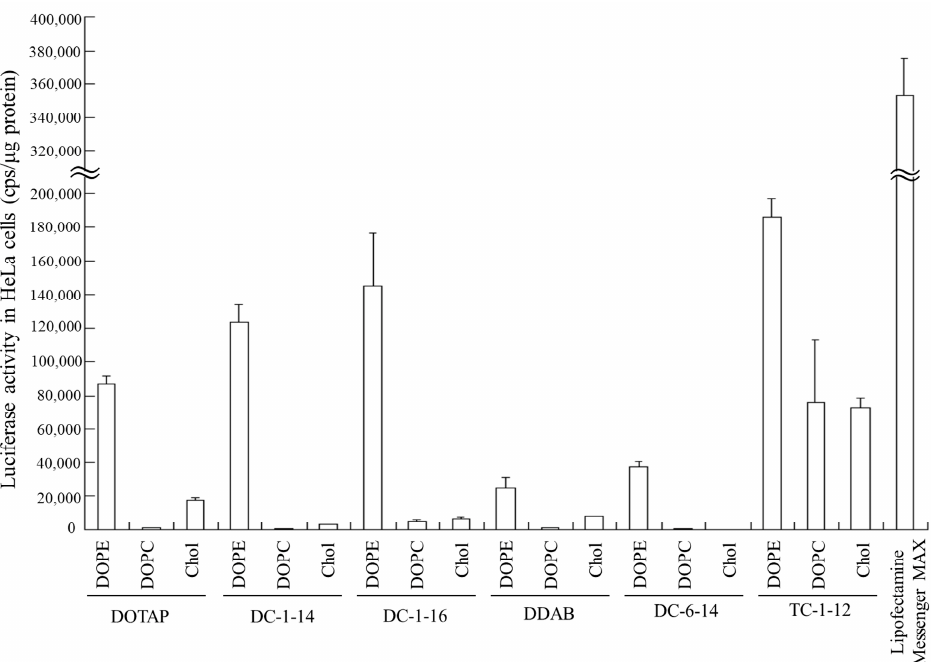
Figure 2. Effect of cationic and neutral helper lipids in mRNA lipoplexes on luciferase expression in HeLa cells after transfection with FLuc mRNA lipoplexes. mRNA lipoplexes with FLuc mRNA were added to HeLa cells at 0.5 µ g/mL mRNA, and luciferase assays were carried out 24 h after incubation. Lipofectamine ® MessengerMAX TM was used as a control for mRNA transfection. Each column represents the mean + S.D. ( n = 3).